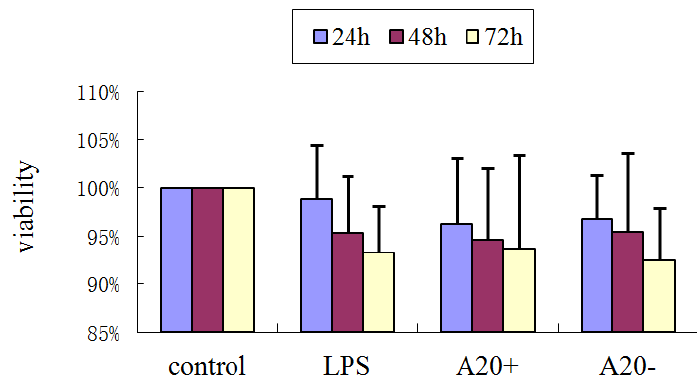
Figure 2. Effects of various treatments on RPMC viability. Cells were treated with serum-free DMEM/F12, serum-free DMEM/F12 + LPS, serum-free DMEM/F12 + pGEM-T easy- A20 + LPS, and serum-free DMEM/F12 + pGEM-T easy + LPS for 24, 48, and 72 h. MTT assays were used to evaluate cell viability. Cells incubated with serum-free DMEM/F12 alone were used as the control and their cell viability was set to 100%. Data are expressed as the mean ± SD of three independent experiments. Control, LPS, A20+, and A20 − represent serum-free DMEM/F12, serum-free DMEM/F12 + LPS, serum-free DMEM/F12 + pGEM-T easy- A20 + LPS, and serum-free DMEM/F12 + pGEM-T easy + LPS, respectively. Compared with the control, there were no significant differences in cell viability ( p >